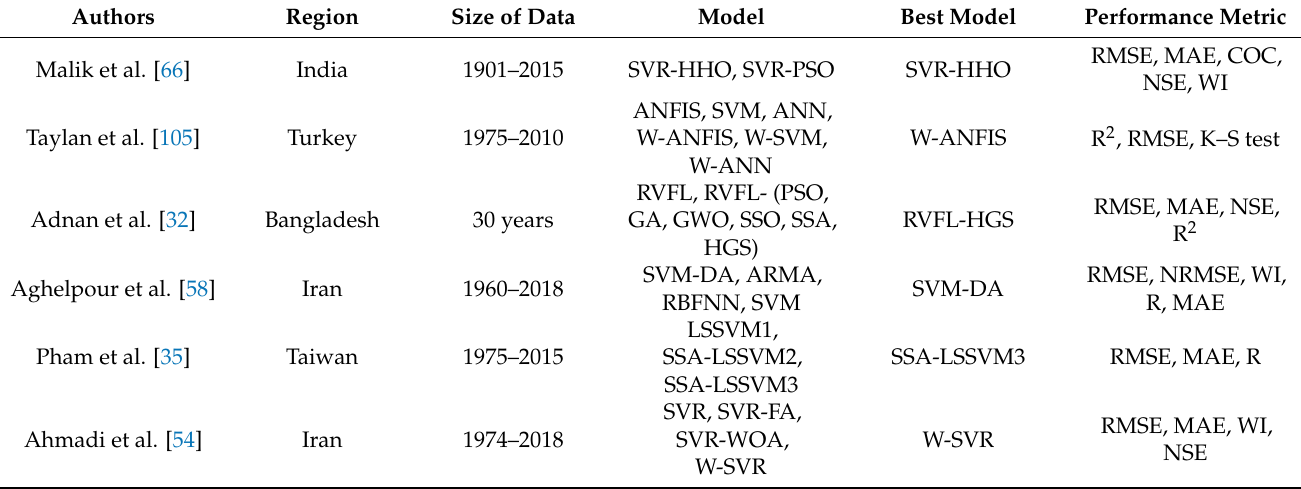
Table 8. Summary of studies applying machine learning models for forecasting drought